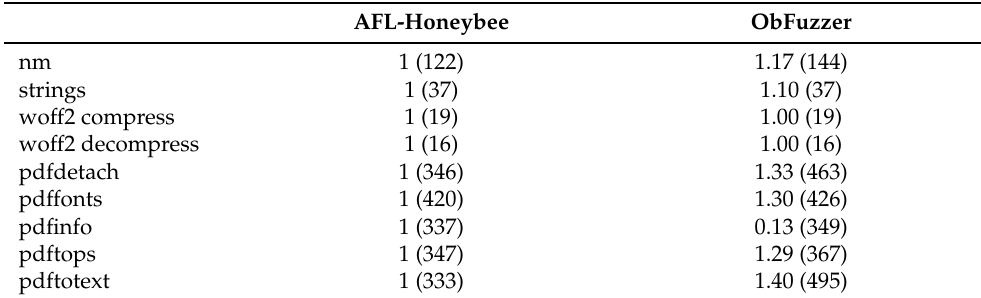
Table 1. This table contains two parts. First, the object operation complexity of ObFuzzer with AFL-Honeybee as the base. Second, the numbers in brackets are the counts of PCPP high score positions executed in the program